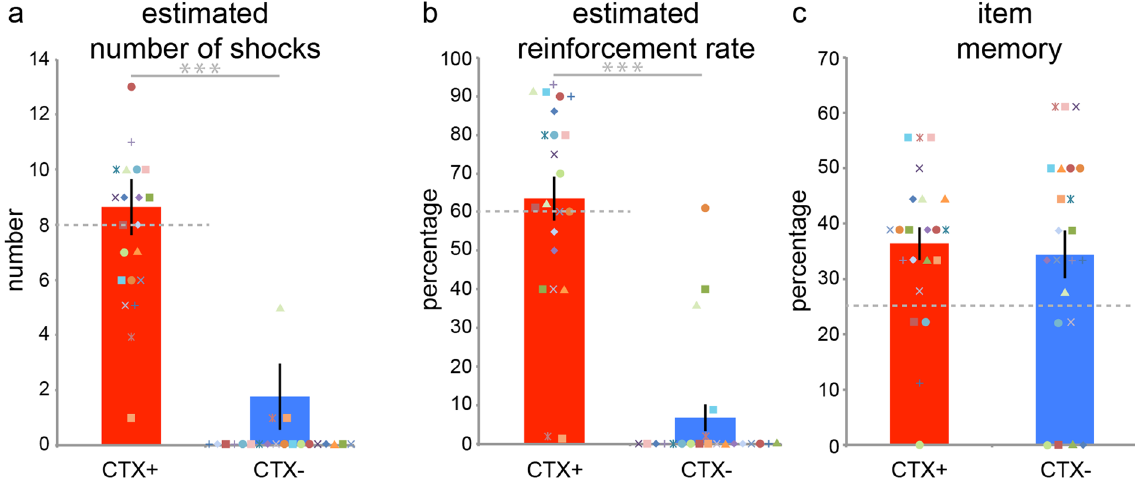
Figure 4. Context conditioning results in acquisition explicit threat memory. Bar plots reflecting mean estimated number of received shocks ( a ) and mean estimated reinforcement rate ( b ) for the threat (CTX + , red), safe context (CTX − , blue) tested at the end of the experiment. Dashed grey line indicates actual number of administered shocks (a: 8 shocks in CTX + only) and actual reinforcement rate ( b ) 60% of CTX + trials featured delivery of shock). Following iVR conditioning, participants accurately estimated having received more shocks in the CTX + than CTX − and associated the CTX + with a higher reinforcement rate then the CTX − . ( c ) Bar plots reflecting mean memory scores on four-alternative choice memory questionnaire testing memory for items that had been present in the CTX + and CTX − . Dashed line indicates chance level (25%). Participants remembered items from both context above change there were no difference in item memory between contexts. Error bars = s.e.m. Coloured geometrical shapes represent individual data-points. *** p <